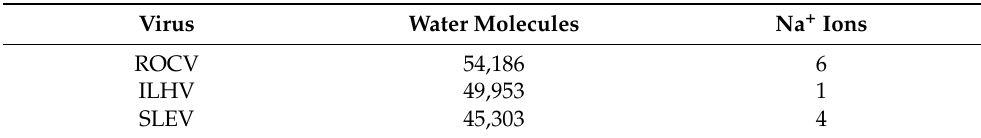
Table 2. Number of molecules added to solvate and neutralize the system. Virus Water